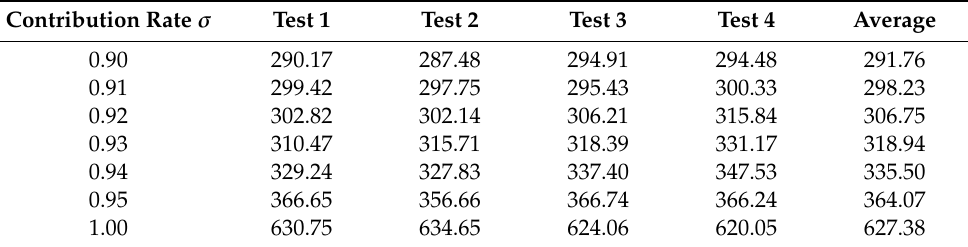
Table 4. Computation time ( s ) of test 1 to test 4 under di ff erent contribution